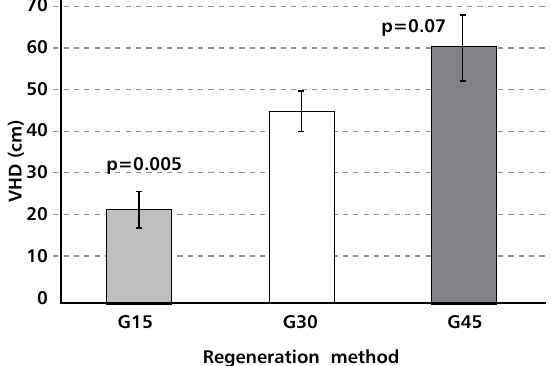
Differences between height of the tallest hornbeam and that of the tallest sessile oak seedlings (VHD) in the fourth year of the regeneration (2008). Height of the tallest sessile oak seedling was subtracted from that of the tallest hornbeam seedling (or sapling) by 1 x 1 m quadrats. Medium-size gaps were compared to the largest and to the smallest ones. Significance levels are given at the bars of the latter gaps. Standard errors are shown by whiskers. Observation